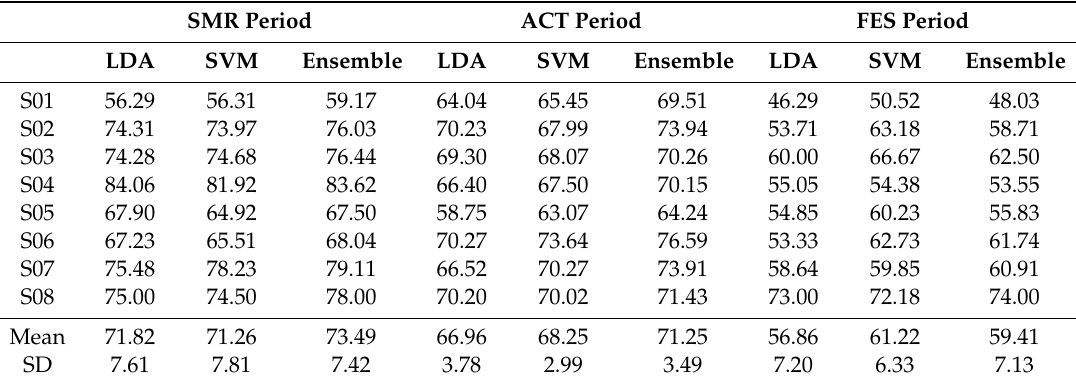
Table 1. Accuracy of each period and classification methods